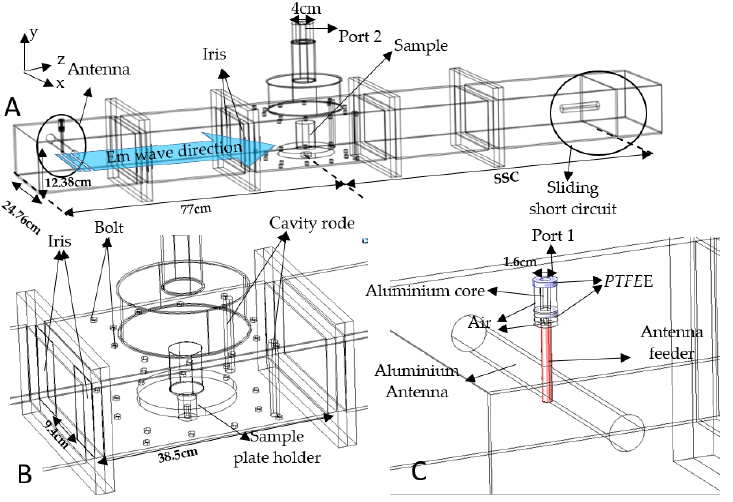
Figure 1. Detailed view of the microwave system’s ( A ) cavity ( B ) and antenna ( C